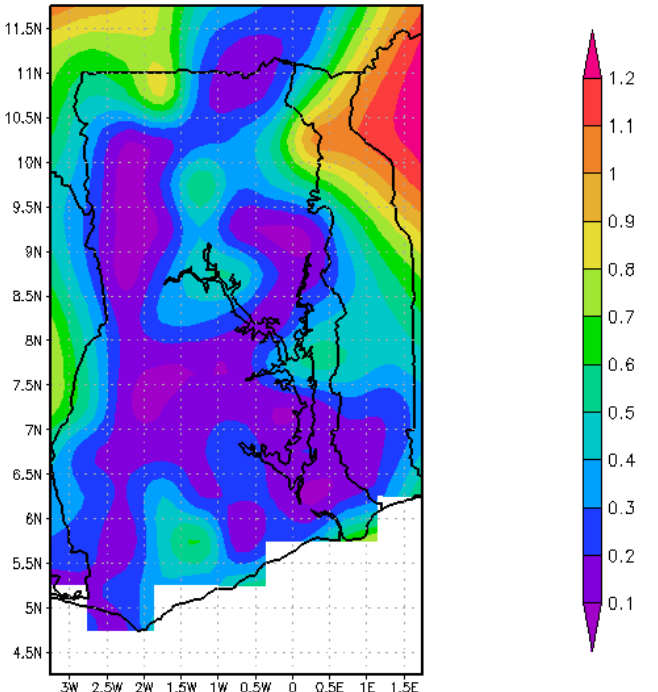
Figure 6. Relative Root Mean Squared Error between GPCC and GMet data from 1980–2010.